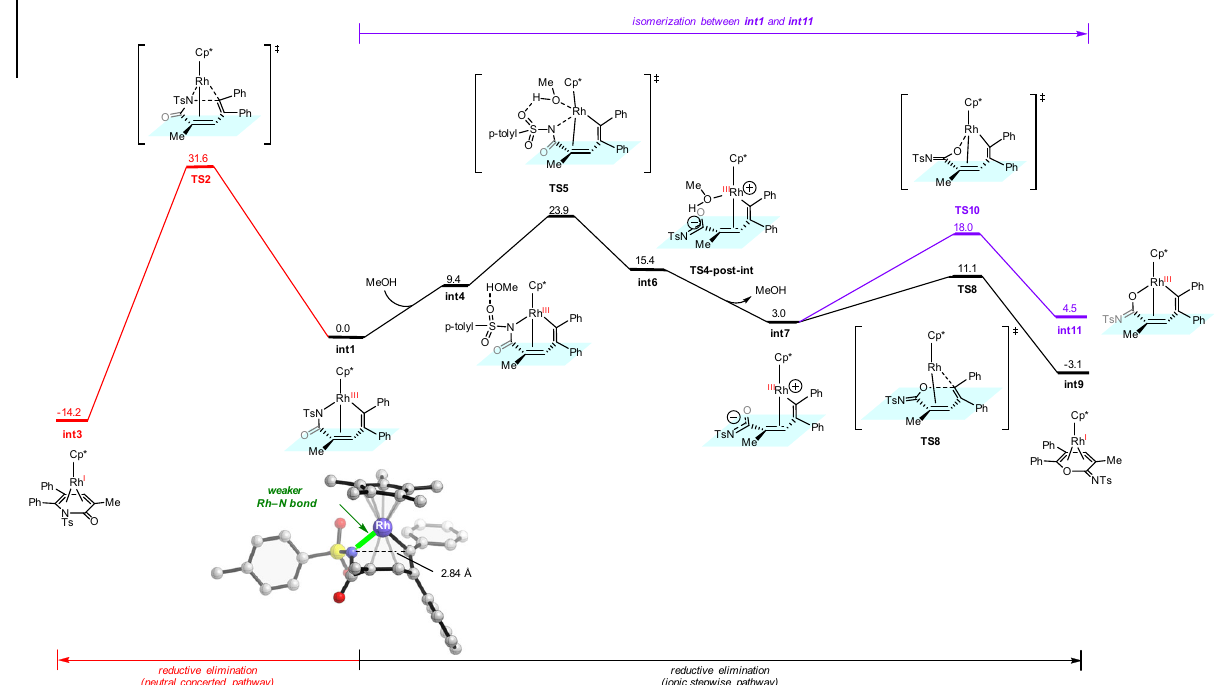
Fig. 7 DFT calculations with 1a substrate. DFT-computed free energy changes of competing reductive elimination pathways from seven-membered ring vinyl-rhodium intermediate when N -tosyl acrylamide 1a was employed as